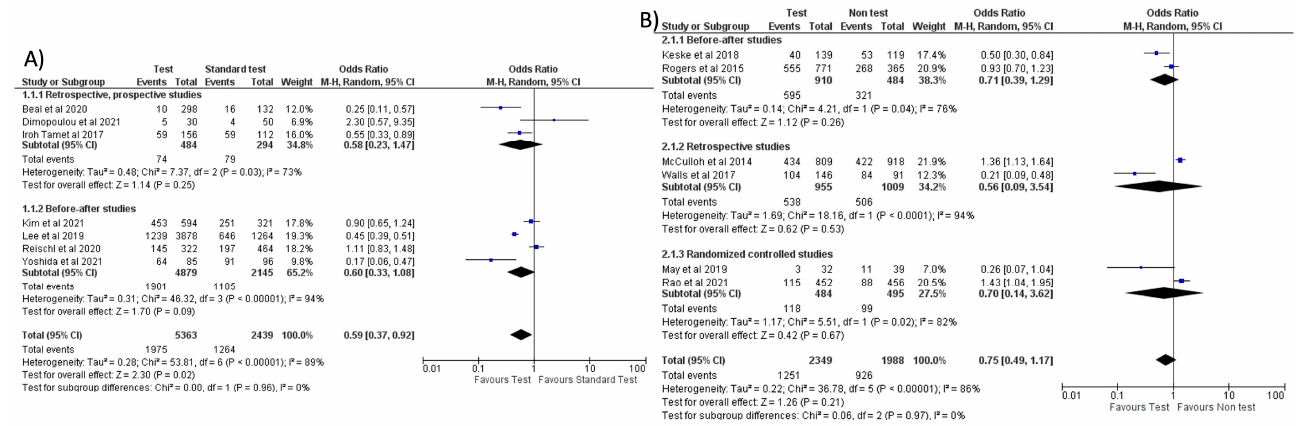
Figure 4. Forest plot of prescription of antibiotics after implementation of FA-RP: ( A ) FA-RP vs. standard test; ( B ) FA-RP versus clinical